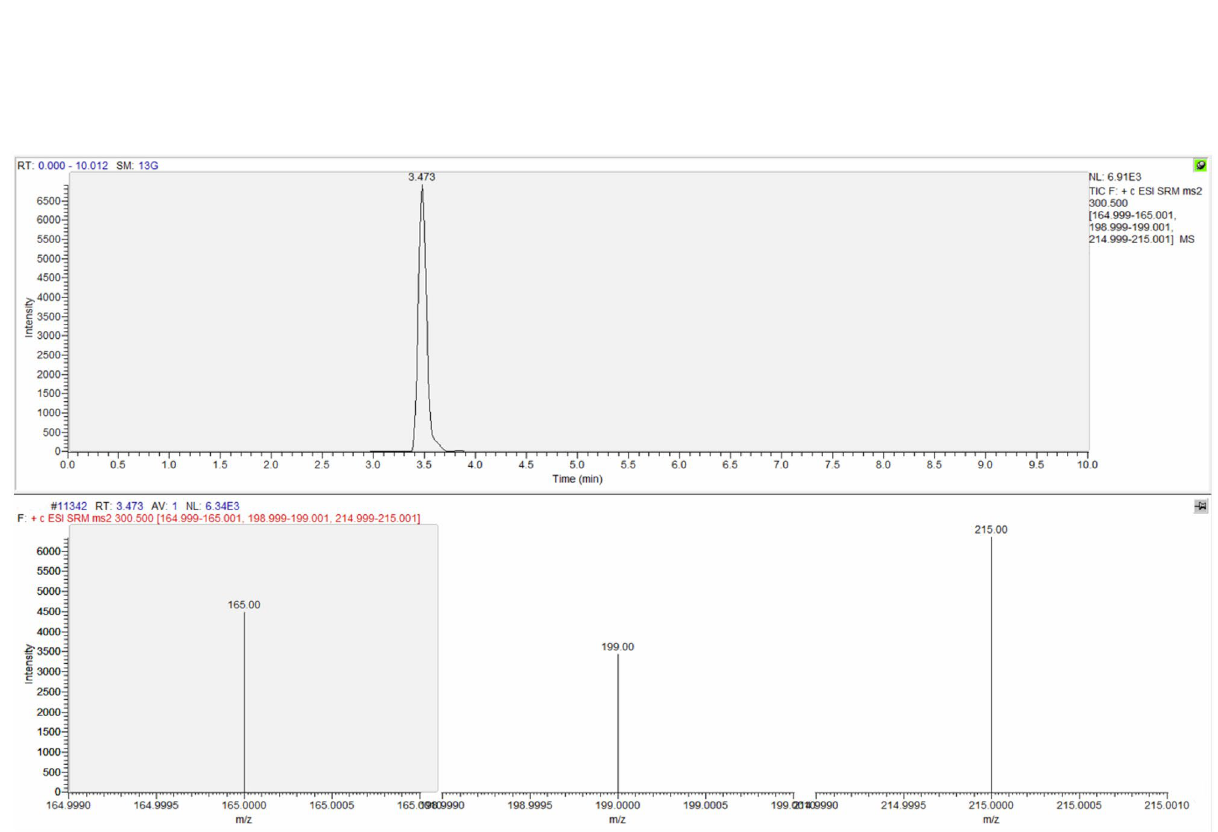
Figure 5. Chromatographic spectrum (upper portion) and mass spectral ion ratio (bottom portion) of codeine detected in